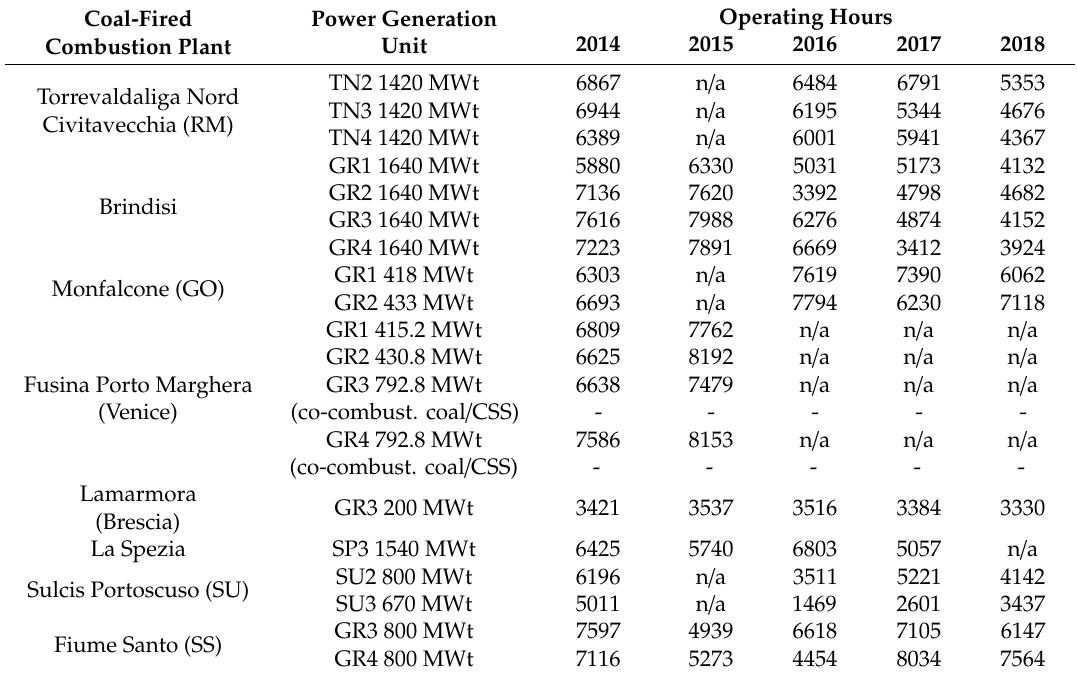
Table 3. Italian coal-fired combustion plants operation (2014–2018) [15].